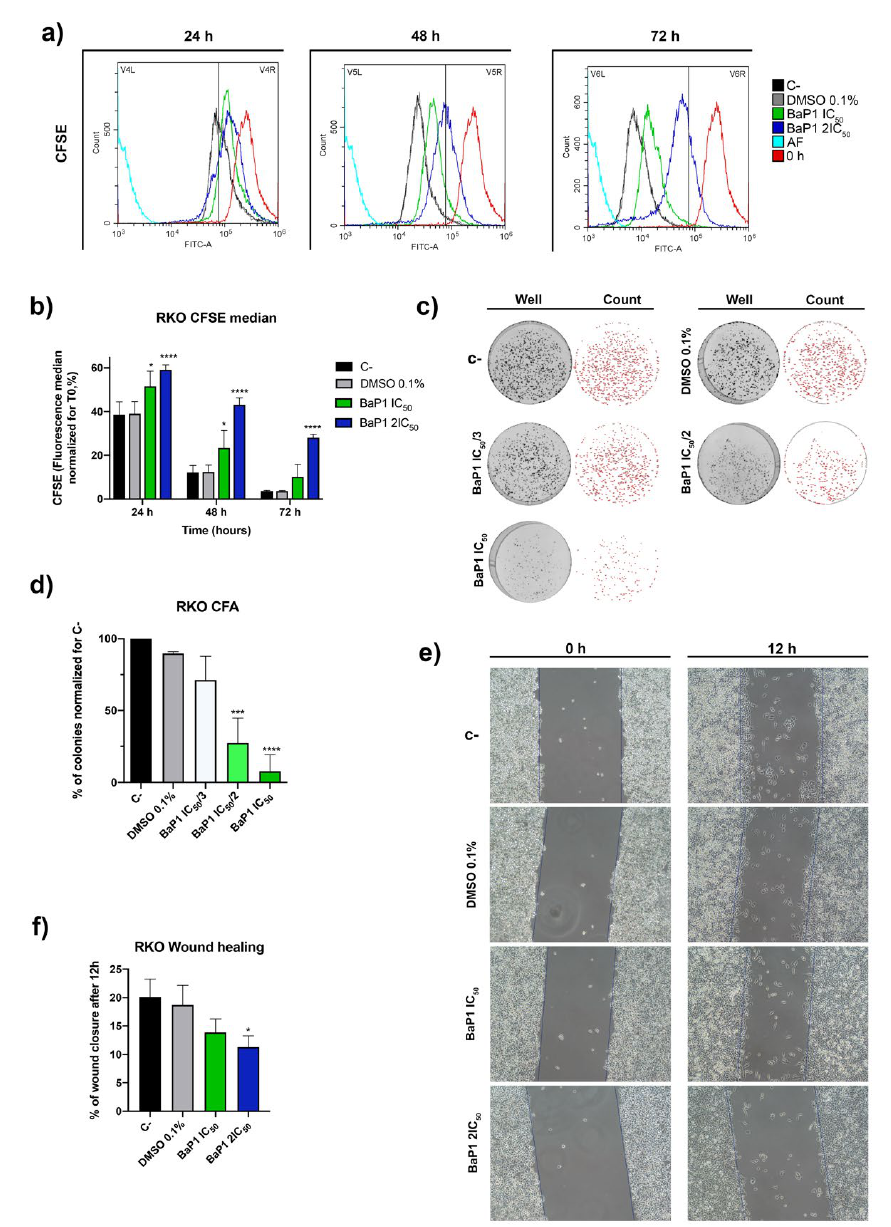
Figure 3. BaP1 biological effects on RKO cell line. ( a ) Representative histograms of RKO cell prolif- eration analysis with Carboxyfluorescein Diacetate Succinimidyl Ester (CFSE) after 0, 24, 48, and 72 h of exposure to BaP1 IC 50 and 2 × IC 50 . Untreated cells (C-) and DMSO (0.1%) exposed cells were used as negative controls. ( b ) Quantification of the CFSE fluorescence median; values normalized to T0 after 24, 48, and 72 h of exposure. Values are means with SD (n ≥ 3). Statistical analysis was performed by two-way ANOVA. * p < 0.05, **** p < 0.0001. ( c ) Representative images of the Colony Formation Assay after exposure to increasing concentrations of BaP1 (IC 50 /3, IC 50 /2, and IC 50 ) for 48 h. Untreated cells (C-) and DMSO (0.1%) exposed cells were used as negative controls. ( d ) Quanti- fication of the number of colonies; values normalized to C- . Values are means with SD (n ≥ 3). Sta- tistical analysis was performed by one-way ANOVA. *** p < 0.001, **** p < 0.0001. ( e ) Representative